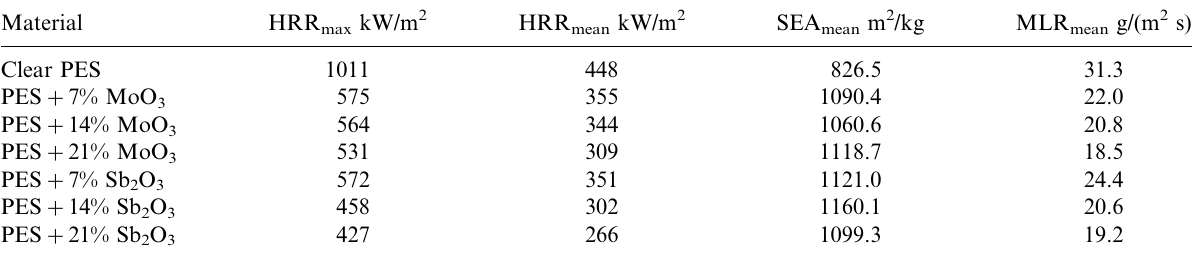
Table 5. Thermokinetic properties of polyester materials containing Polimal 1033 APy unmodified and modified with inorganic oxides under ignition conditions for the external heat flux of 50 kW/m 2 (cid:2) Part 1 Material